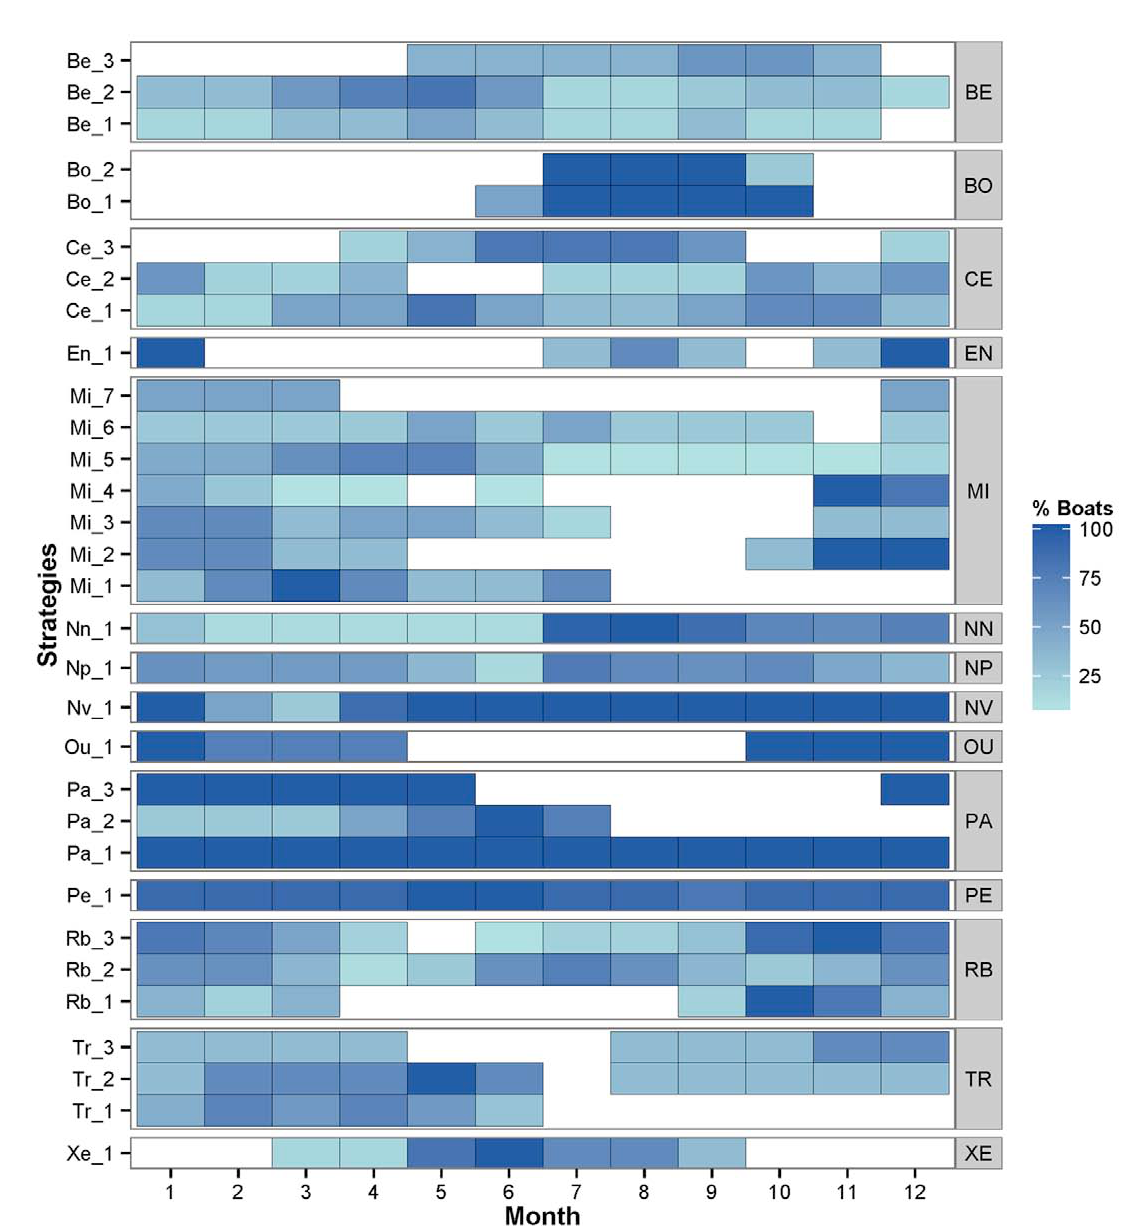
Fig. 5. – Seasonal variation in the use of the fishing strategies. The gradient colour shows the proportion of boats using a particular strategy per month related to the total of boats using that